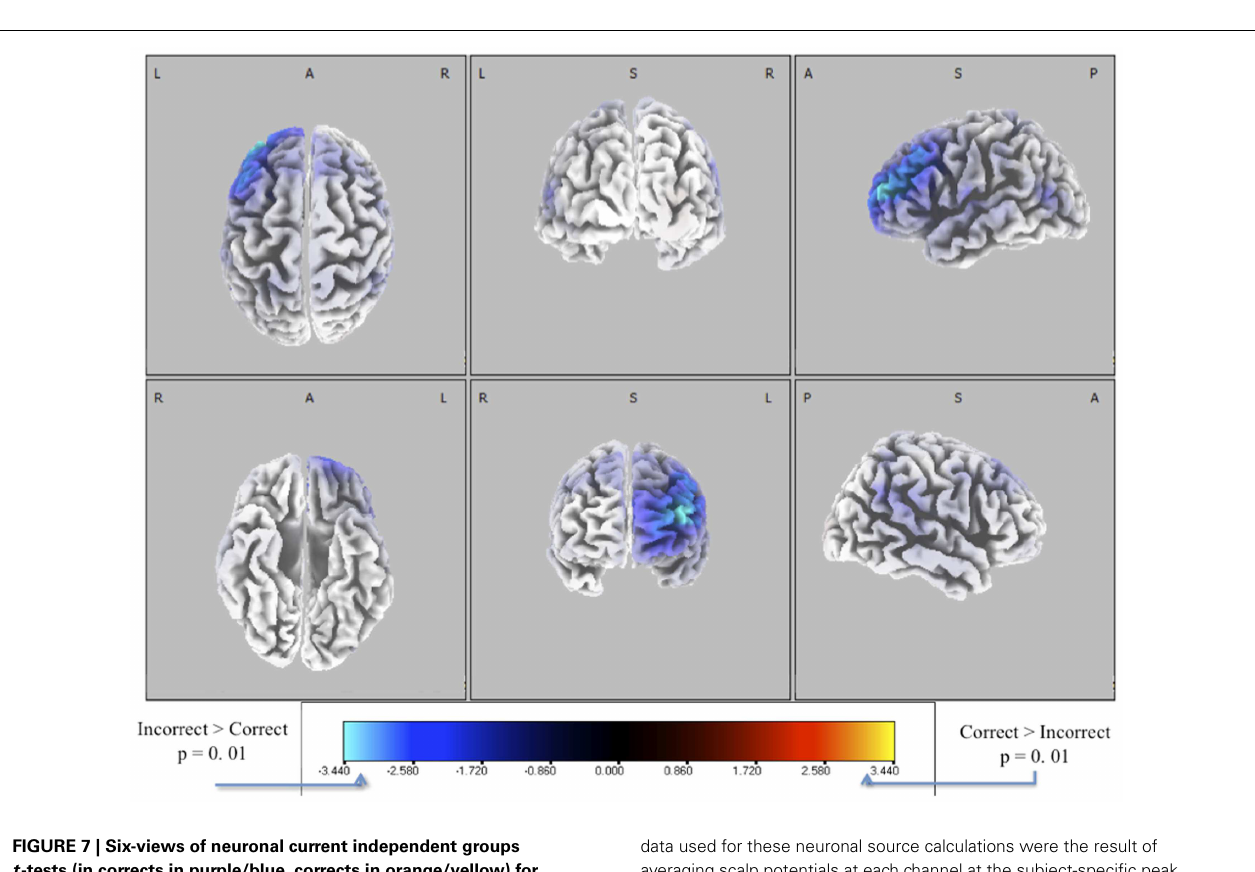
FIGURE 7 | Six-views of neuronal current independent groups t -tests (in corrects in purple/blue, corrects in orange/yellow) for all pitches combined. In both plots, the log of the F -ratio for each voxel is shown [ F (1, 13)] with brighter colors indicating higher values of the t -statistic according to the color scale. Significance was established with a permutation test (5000 permutations).The EEG